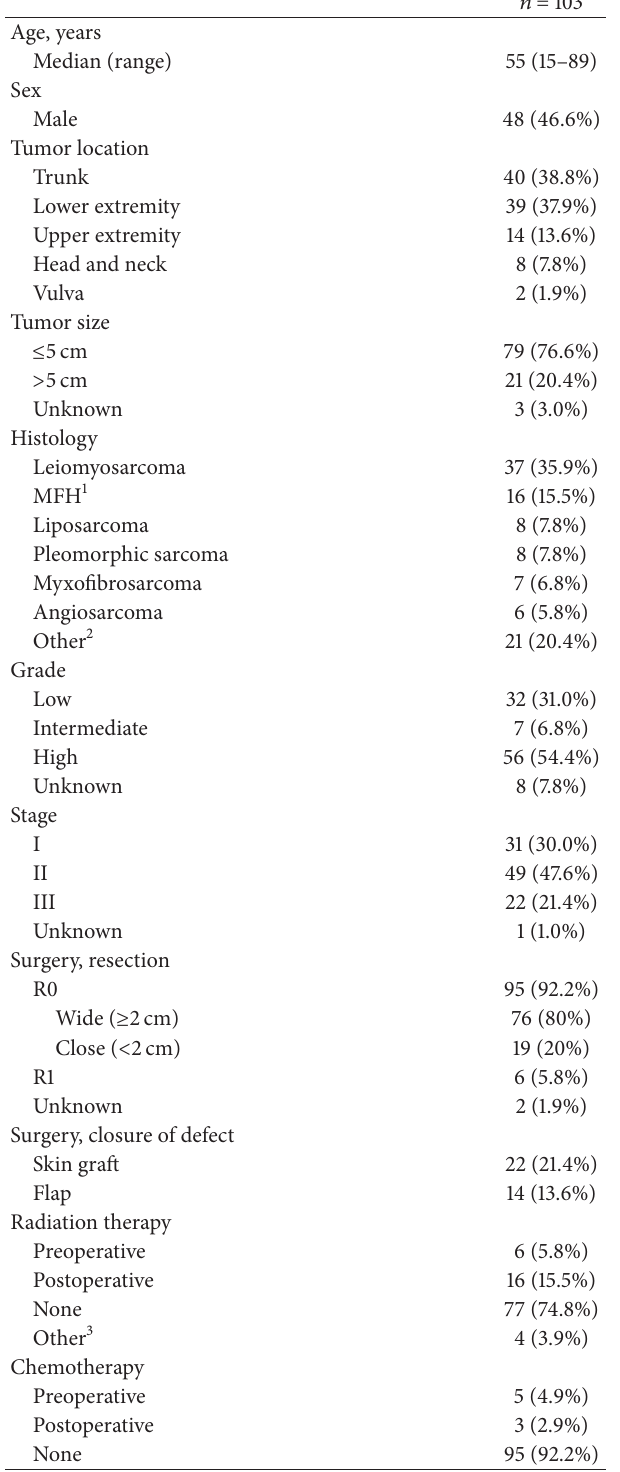
Table 1: S-STS patient demographics, disease characteristics, and management.